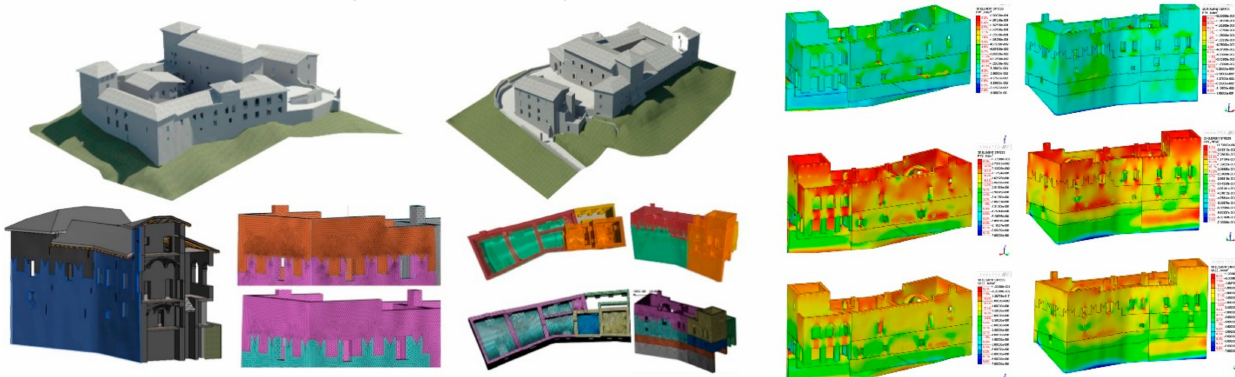
Figure 14. Mesh model used for FEA. Management of model conversion from NURBS to mesh object allows professionals to improve structural simulation and obtain a detailed analysis